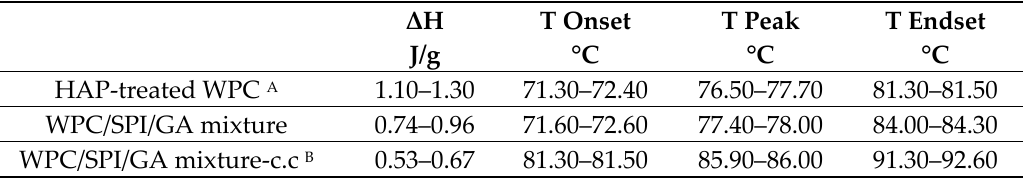
Table 1. DSC parameters for wall material dispersions.